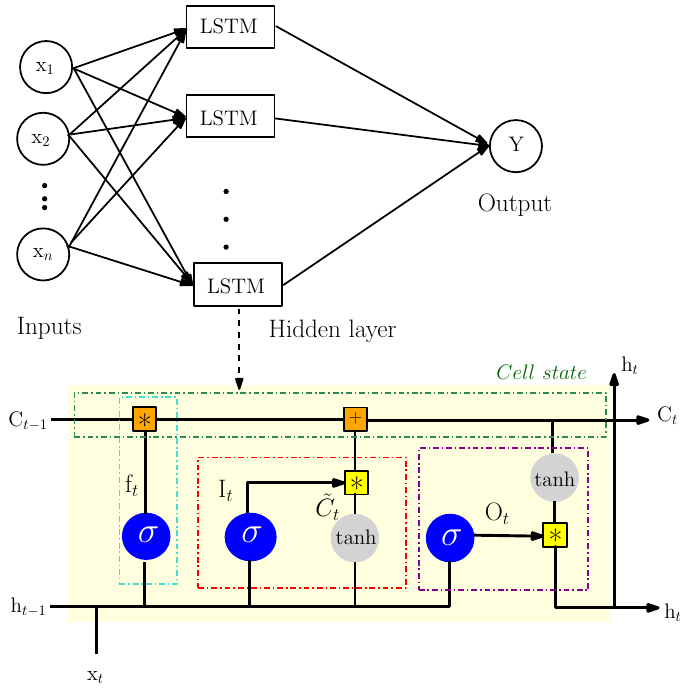
Figure 4. A typical Long Short-Term Memory (LSTM) network